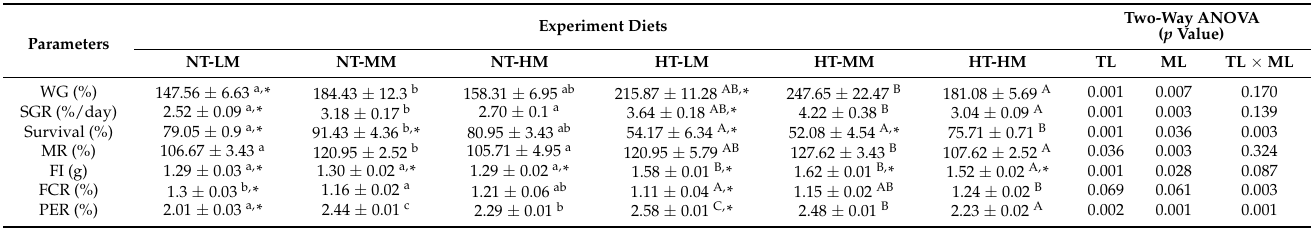
Table 4. The growth performance of juvenile E. sinensis fed the experimental diets at different water temperatures and dietary methionine levels (mean ± SEM) ( n = 4 replicate tanks).